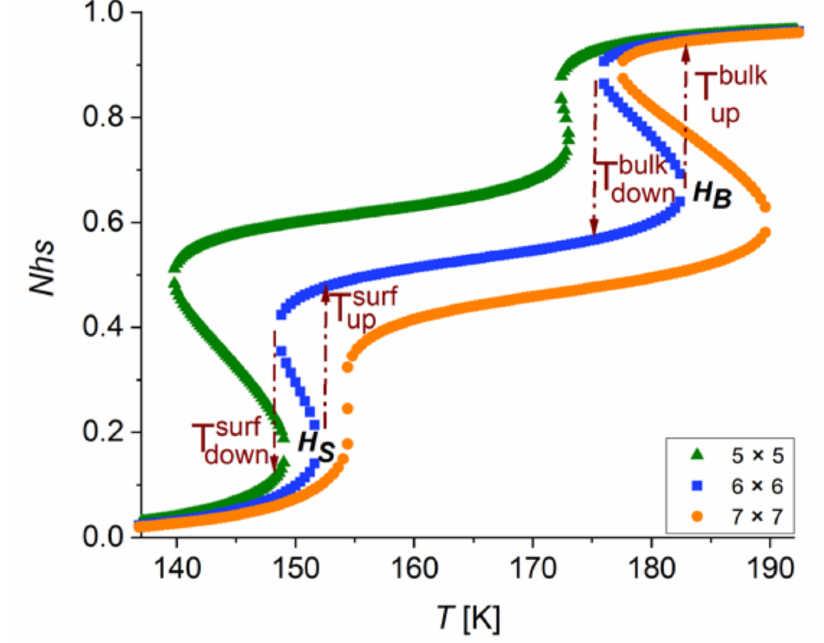
Figure 8. Thermal evolution of the HS fraction for different lattice sizes: 5 × 5 (green up triangle), 6 × 6 (blue squares), 7 × 7 (orange circles). The computational parameters are: ∆ / k B = 1300 K, L / k B = 290 K, G / k B = 172 K, J bb / k B = 60 K, J ss / k B = 50 K, J bs / k B = 20 K and ln( g ) =